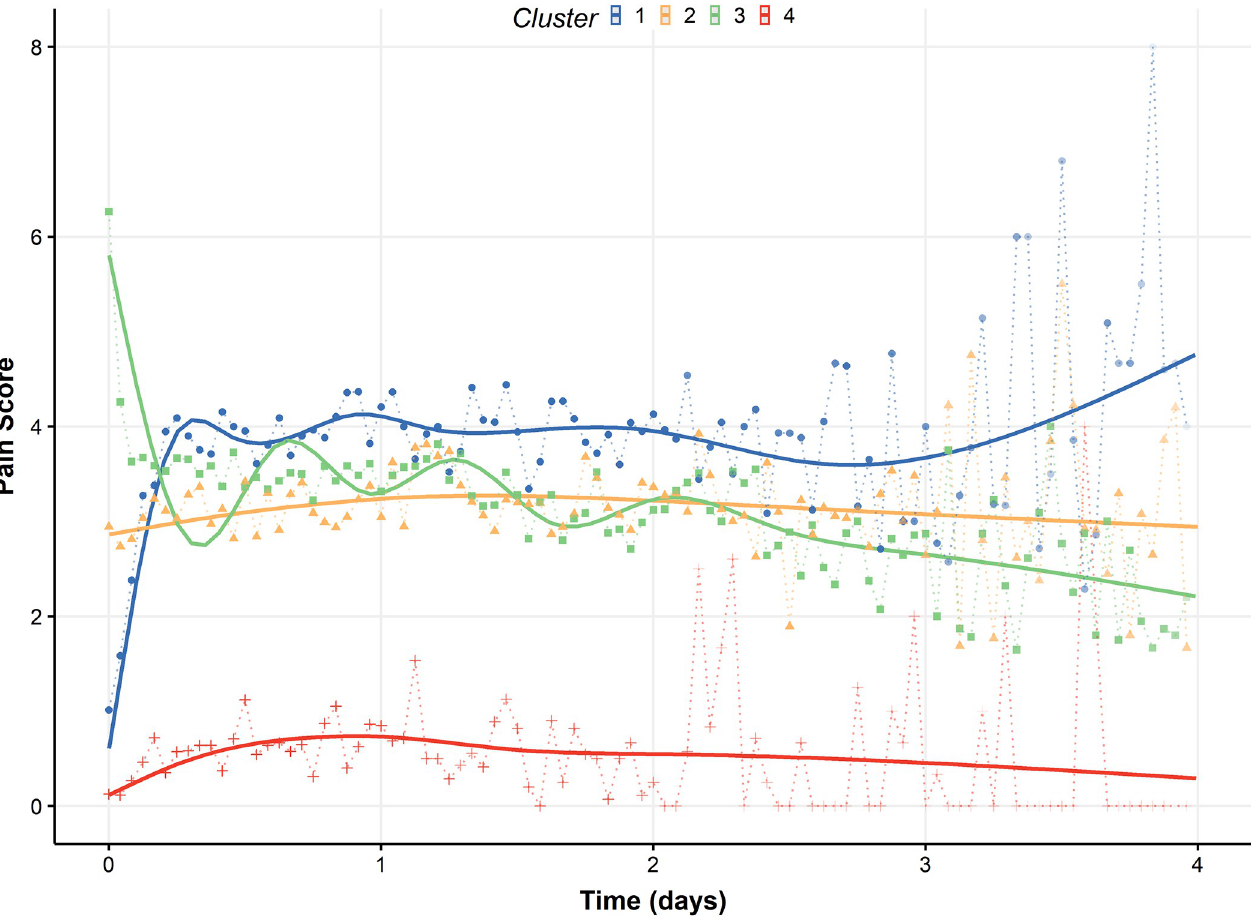
Fig 2. Estimated acute pain trajectories by cluster. The points and the dotted lines represent the mean acute pain of patients during each hour of observation. The solid lines show loess-smoothed pain trajectories. Areas under the curve (AUC) for each cluster (1–4) are 549095, 519615, 667908, and 877505,